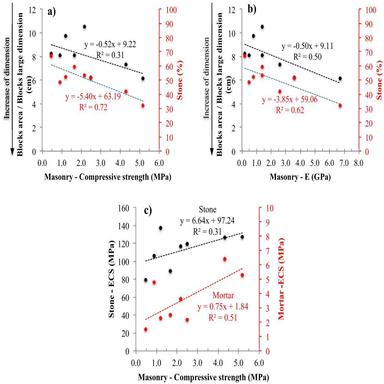
Influence of stone size and amount of stone on the compressive strength (a) and Young's modulus (b) values of the tested walls; influence of stone and mortar compressive strength on the compressive strength (c) values of the tested walls.